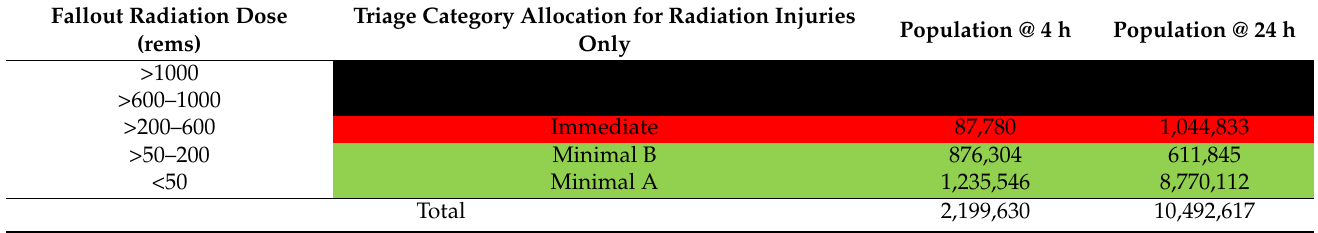
Table 5. Human casualties from fallout radiation only (1 × 25 kt nuclear weapon).